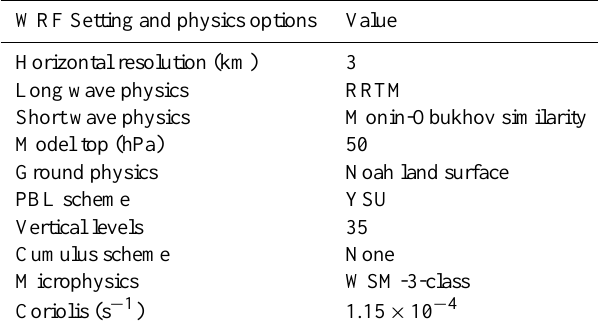
Table 1. WRF model and physics specifications used for the single coast baseline